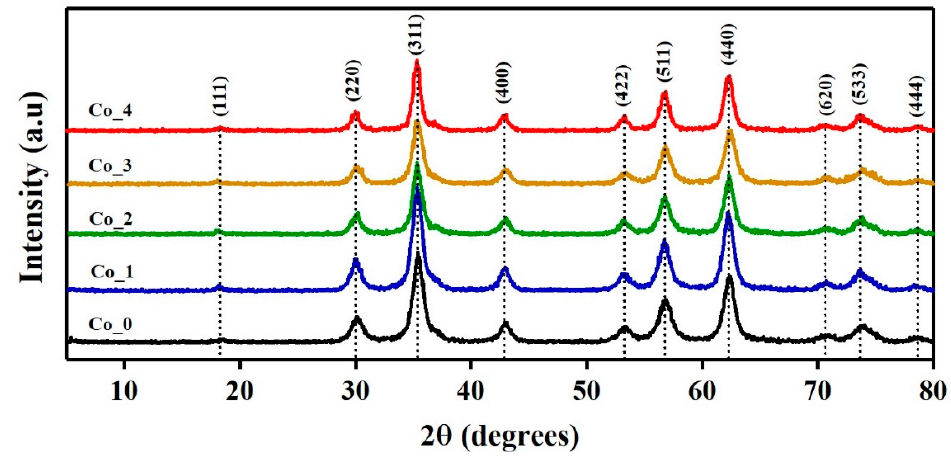
Figure 1. X-ray powder diffraction (XRPD) patterns of Co x Zn 1-x Fe 2 O 4 ferrite systems.